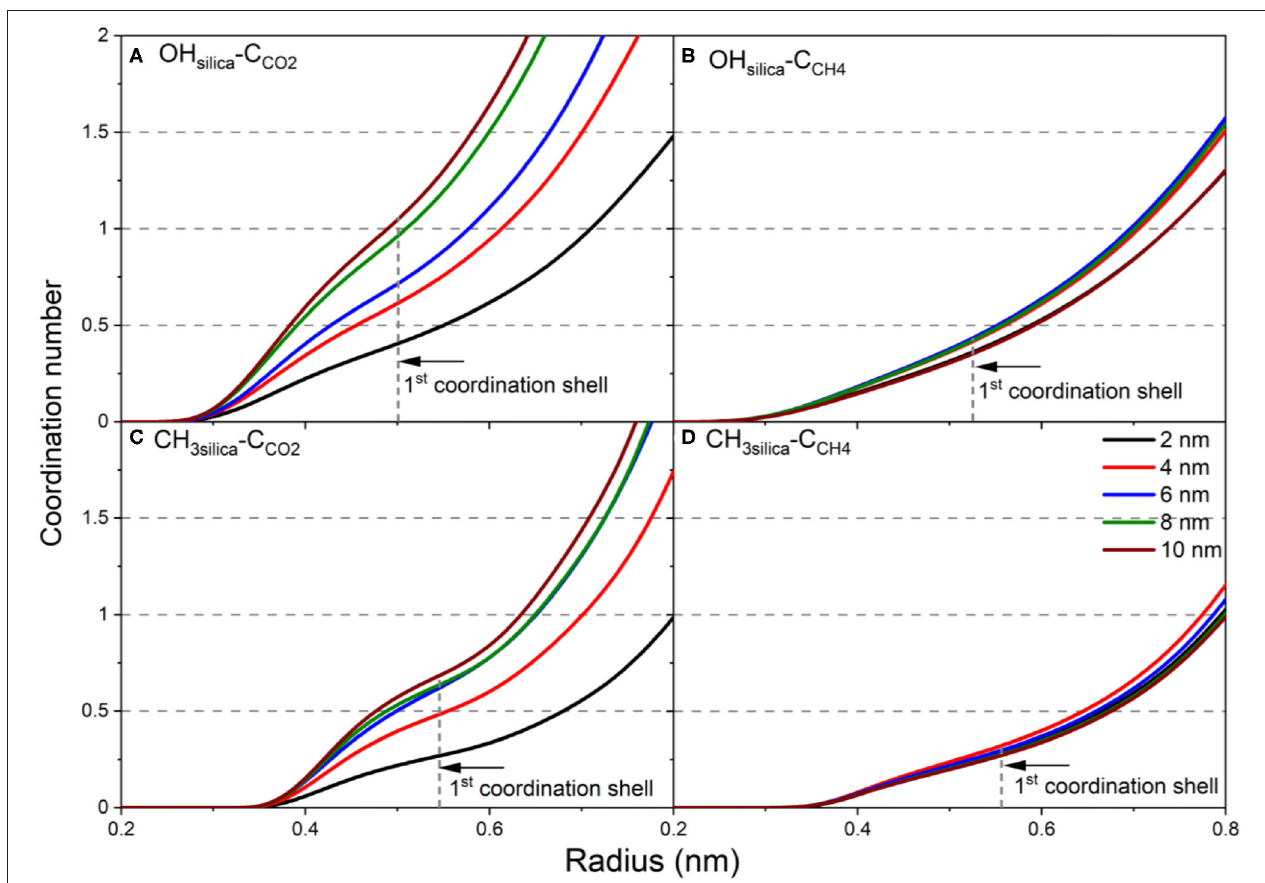
FIGURE 8 | The coordination number of (A) C CO2 from OH silica , (B) C CH4 from OH silica , (C) C CO2 from CH 3silica , and (D) C CH4 from CH 3silica as a function of the pore diameter. The coordination number is calculated by integrating the radial distribution function and is averaged over the last 10 ns of the simulation